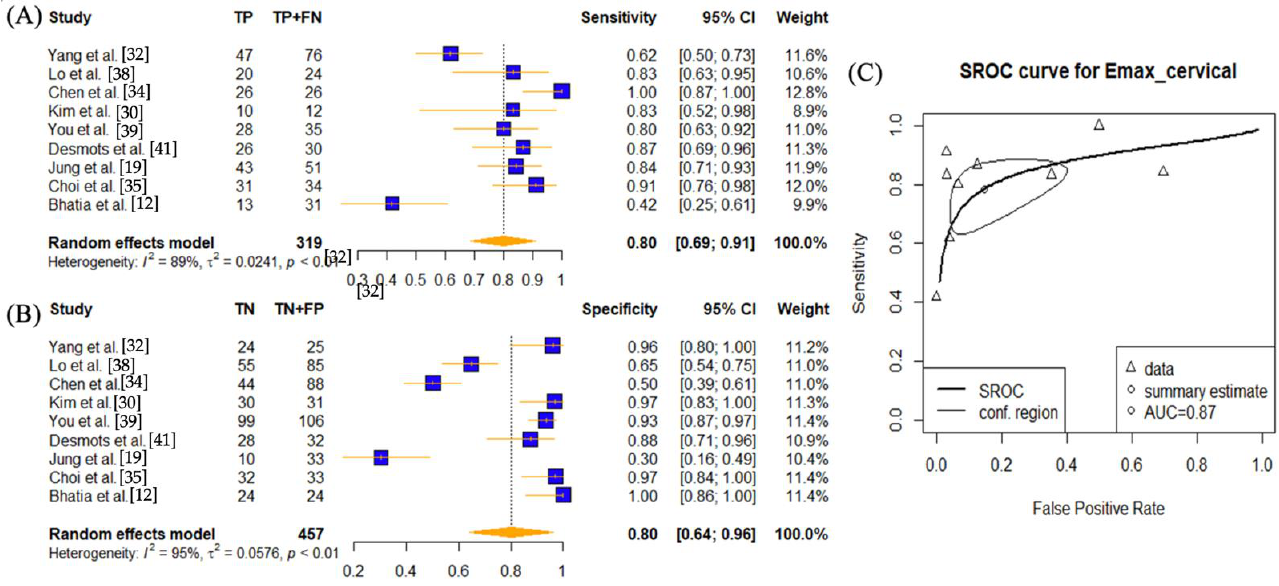
Figure 7. Sensitivity and specificity forest plots and overall accuracy results of E max in cervical (in- cluding thyroid) LNs. (( A – C ) Reported sensitivity and specificity values for E max values per select- ed study with AUC value on SROC curve for the analysis of E max . Forest plots for pooled sensitivi- ties and specificities are displayed as diamonds in the graphs for E max ( A , B ). The SROC curve indi- cates the summary estimates in circles (( C ) for E max ). Triangles represent included study with dot- ted lines representing the confidence interval and solid line for the SROC. AUC value is displayed (in the legend). E max — maximum tissue stiffness SWE parameter; AUC — area under the curve; SROC — summary receiver operating characteristic.